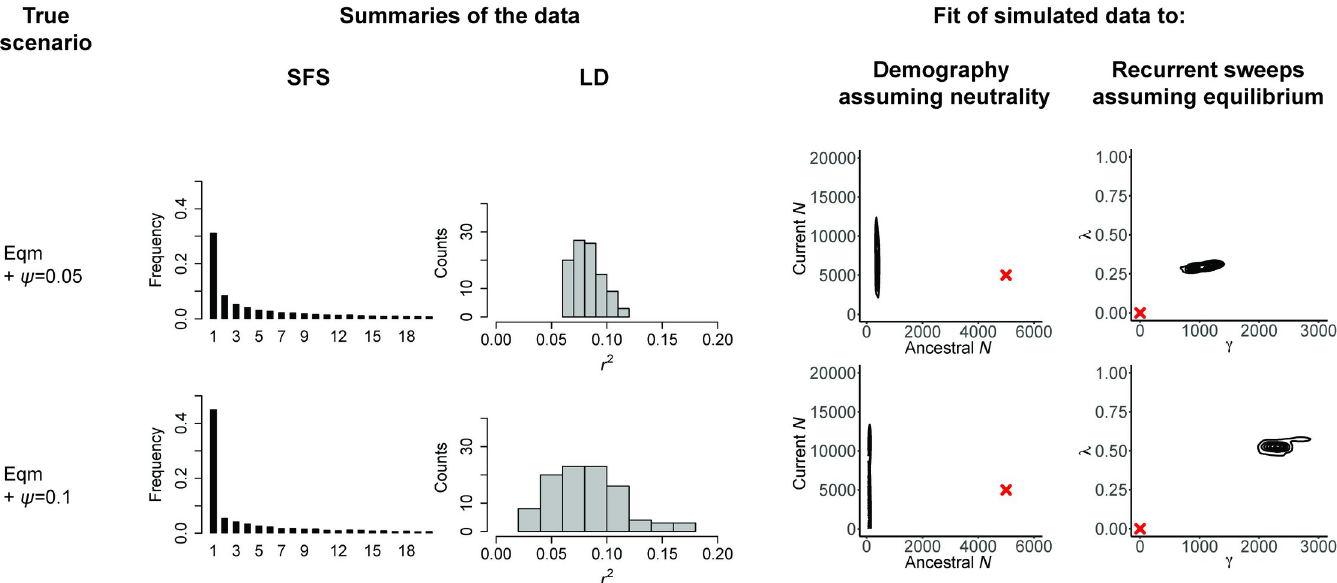
Fig 3. The impact of potential model violations can be quantified. As in Figs 1 and 2, the scenarios are given in the first column, here, equilibrium population size together with a moderate degree of progeny skew (“Eqm + ψ = 0.05”) as well as with a high degree of progeny skew (“Eqm + ψ = 0.1”) (see Methodology); the middle columns present the resulting SFS and LD distributions, and the final columns provide the joint posterior distributions when the data are fit to 2 incorrect models: a demographic model assuming neutrality and a recurrent selective sweep model assuming equilibrium population size. Red crosses indicate the true values. As shown, this violation of Kingman coalescent assumptions can lead to drastic mis-inference, but the biases resulting from such potential model violations can readily be described. The scripts underlying this figure may be found at https://github.com/paruljohri/Perspective_Statistical_Inference/tree/main/SimulationsTestSet/Figure3. LD, linkage disequilibrium; SFS, site frequency